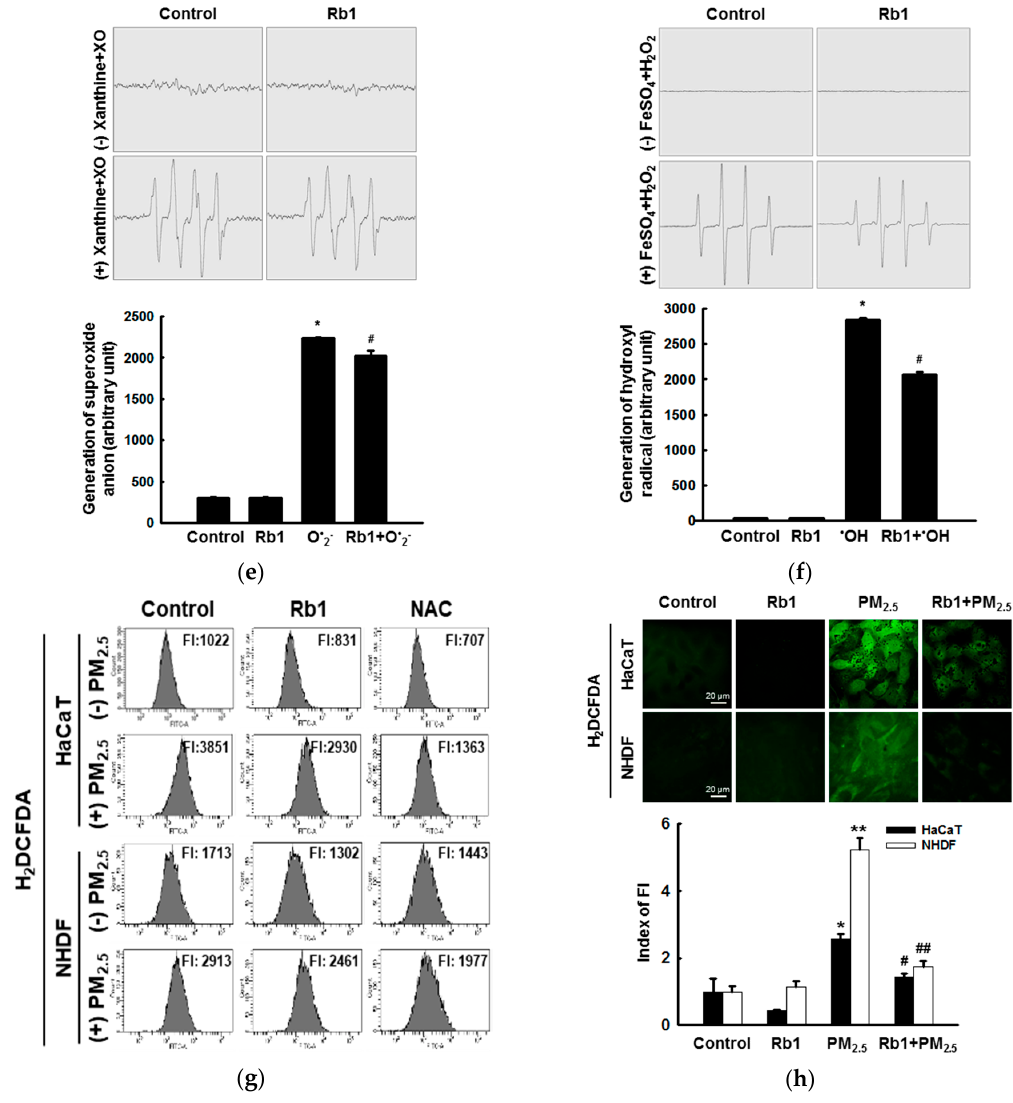
Figure 2. Ginsenoside Rb1 confers protection from PM 2.5 -induced intracellular reactive oxygen species (ROS). ( a ) Chemical structure of ginsenoside Rb1. ( b ) Cells were seeded, and ginsenoside Rb1 was added at final concentrations of 10, 20, 30, 40, and 50 µM. After 24 h, cell viability was determined using the MTT assay. ( c , d ) Cells were pre-treated with ginsenoside Rb1 (40 µM) for 1 h, treated with PM 2.5 (50 µg/mL), incubated for 24 h, ( c ) stained with trypan blue reagent, and visualized using a phase contrast microscope to evaluate cell viability. Black arrows indicate dead cells and white arrows indicate PM 2.5 . ( d ) Cell viability was assessed using MTT assay. ( e ) Superoxide anions generated by the xanthine/xanthine oxidase system were reacted with DMPO and the resultant DMPO/·OOH adducts were detected using ESR spectrometry. * p < 0.05 compared to the control; # p < 0.05 compared to superoxide anions. ( f ) Hydroxyl radicals generated by the Fenton reaction (H 2 O 2 +FeSO 4 ) were reacted with DMPO and the resultant DMPO/·OH adducts were detected by ESR spectrometry. * p < 0.05 compared to the control; # p < 0.05 compared to hydroxyl radicals. ( g, h ) Cells were pre-treated with ginsenoside Rb1 or NAC for 1 h and then treated with PM 2.5 for the indicated time periods. ROS levels were assessed by ( g ) flow cytometry and ( h ) confocal microscopy after H 2 DCFDA staining (FI: Fluorescence intensity). ( c , d , h ) *,** p < 0.05 compared to the control groups of both HaCaT and NHDF cells, respectively; # , ## p < 0.05 compared to PM 2.5 -treated groups of both HaCaT and NHDF cells, respectively.